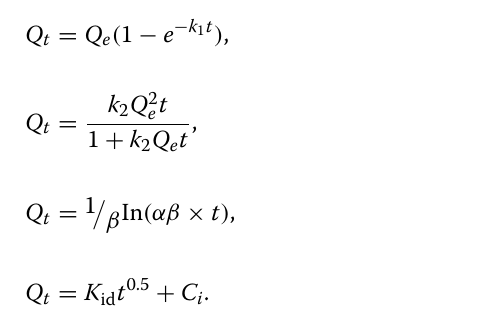
45 °C; pH 5.5; agitation time = =